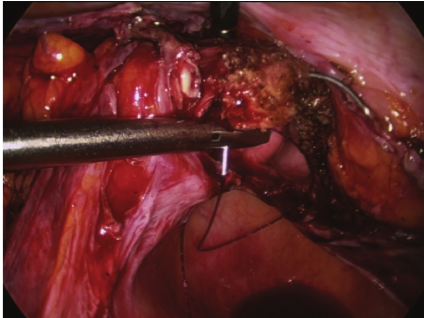
Figure 4: The bladder peritoneum has been sutured to the peri- toneum of the anterior cul-de-sac so as to cover the raw cut edges of the vagina, while allowing drainage laterally. Note that the USLs are prominently providing support to the apex but not overly